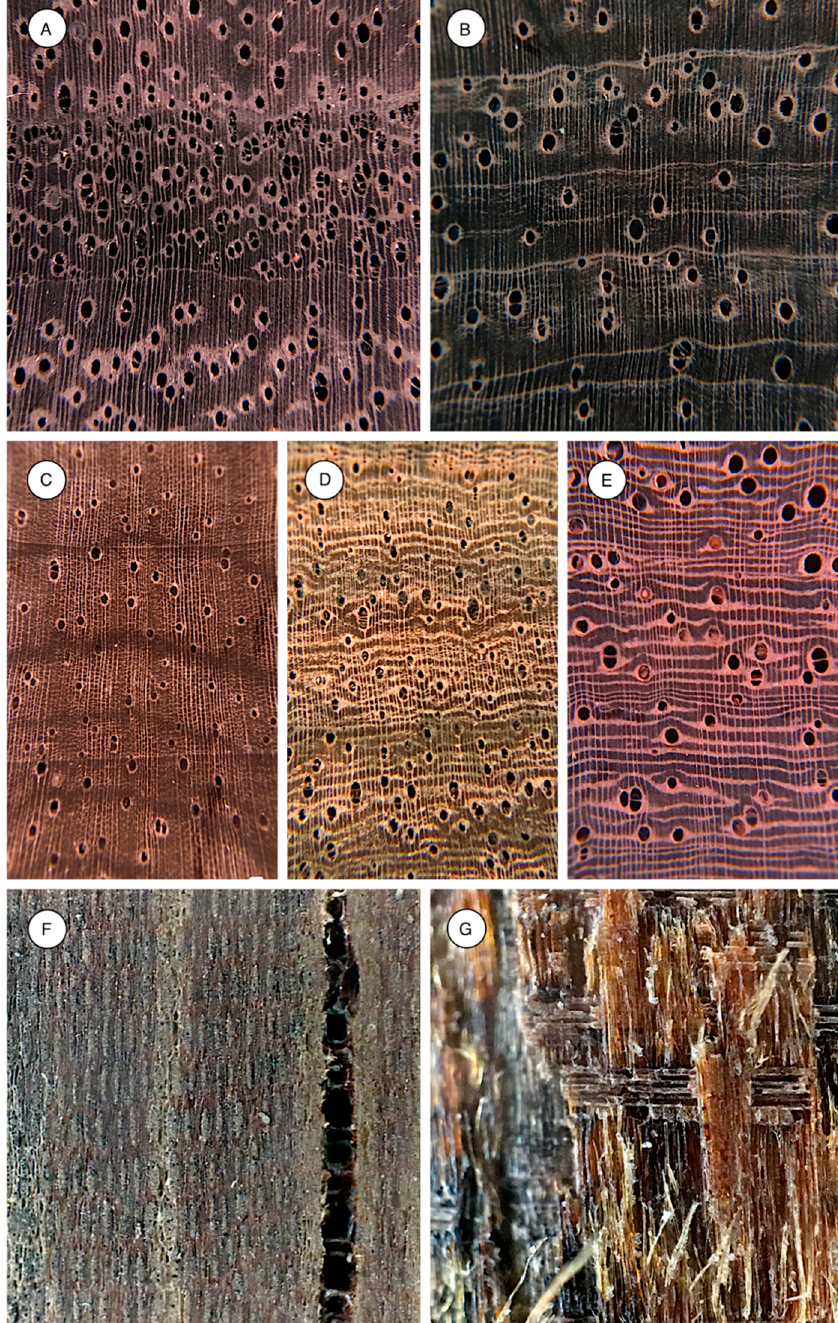
Figure 7. Elements visible with 400 × lens in hardwoods. Dalbergia spp. ( A ) D. latifolia Roxb. ( B ) D. nigra . ( C ) D. retusa . ( D ) D. sissoo Roxb. ex DC. ( E ) D. stevensonii Standl. ( F ) Storied rays in D. nigra . ( G ) Procumbent body ray cells with one row of upright and / or square marginal cells in D. nigra .